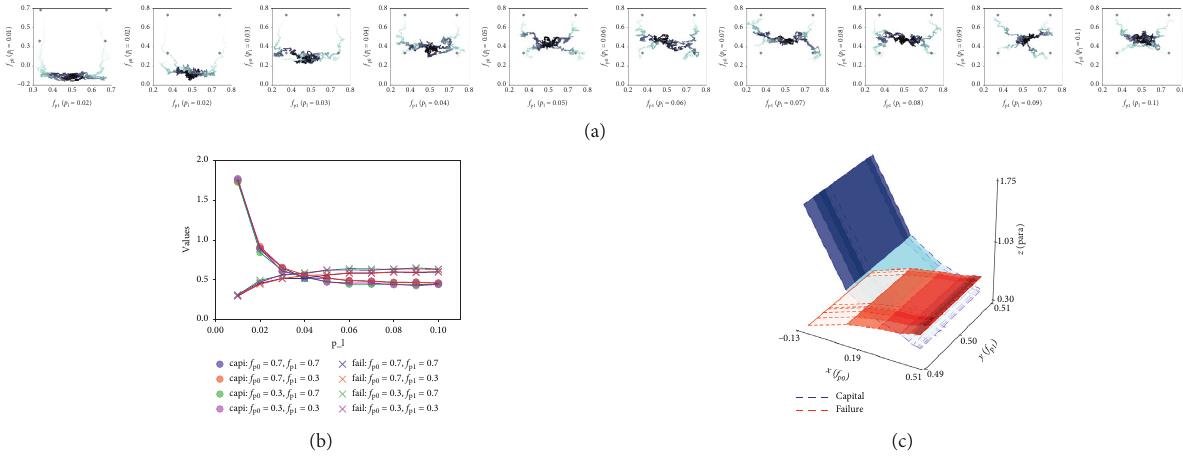
Figure 9: Stationary observation according to the time step. The plots of the upper side show their averaged trajectories (asterisk � initial points of the strategies, strength of the color � time steps: t � 1(weak) ∼ t � 4000 (strong), dots � averaged value of the trait according to time step from � 0.7, f � 0.7, upper left: f � 0.7, f � 0.3, bottom right: f � 0.3, f � 0.7, and bottom left: f � 0.3, the initial points; upper right: f p0 p1 p0 p1 p0 p1 p0 f � 0.3). The plot of the bottom left side shows the averaged outcome values (vertical axis) of the capital (marker � ˆx) and the failure p1 (horizontal axis) with different initial points of the strategies (see legend). The plot of the bottom right side (marker � X ) according to the p l shows the average capital (blue) and failure (red) probability as functions of the strategies ( f , f ) with three-dimensional p0 p1